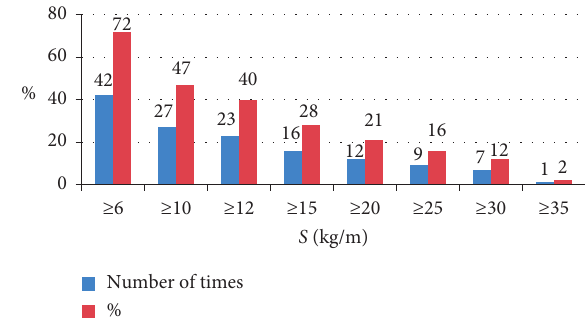
Figure 28: Distribution of 58 sets of prediction cycle drilling chip amount index S 1max .